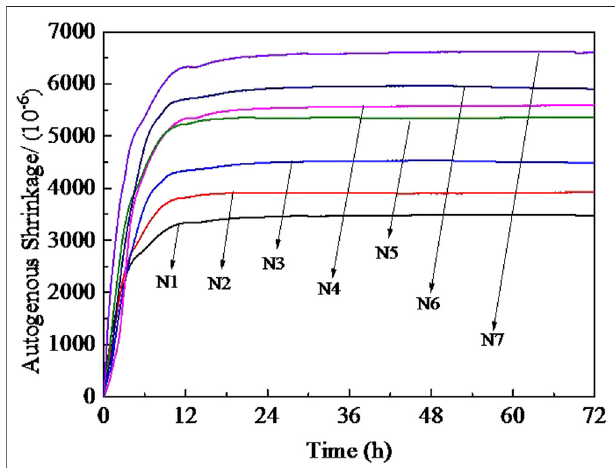
FIGURE 7 | Effect of Sika on auto-shrinkage of UHPC.